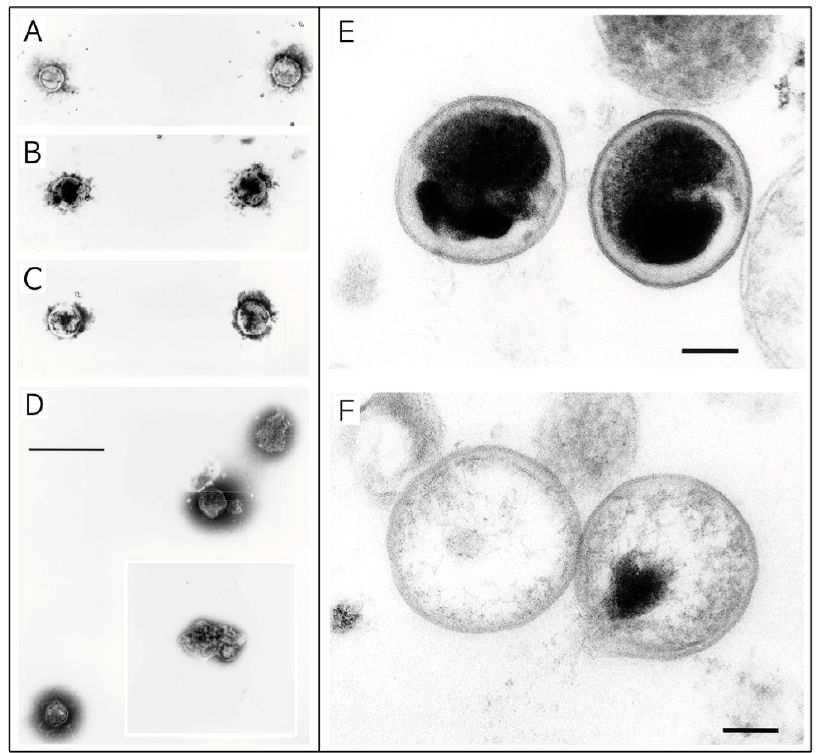
Figure 4. Scanning electron microscopy images of C. trachomatis with and without exposure to lipidic compounds. ( A – D ) Exposure of C. trachomatis EBs to monocaprin; The EBs were untreated ( A ) or treated with 10 mM monocaprin for 1 min ( B ); 5 min ( C ); and 10 min ( D ); With 10 min exposure the EBs appear deformed or disrupted ( D , inset); Bars, 1 μ m. ( E , F ) Exposure of C. trachomatis EBs to